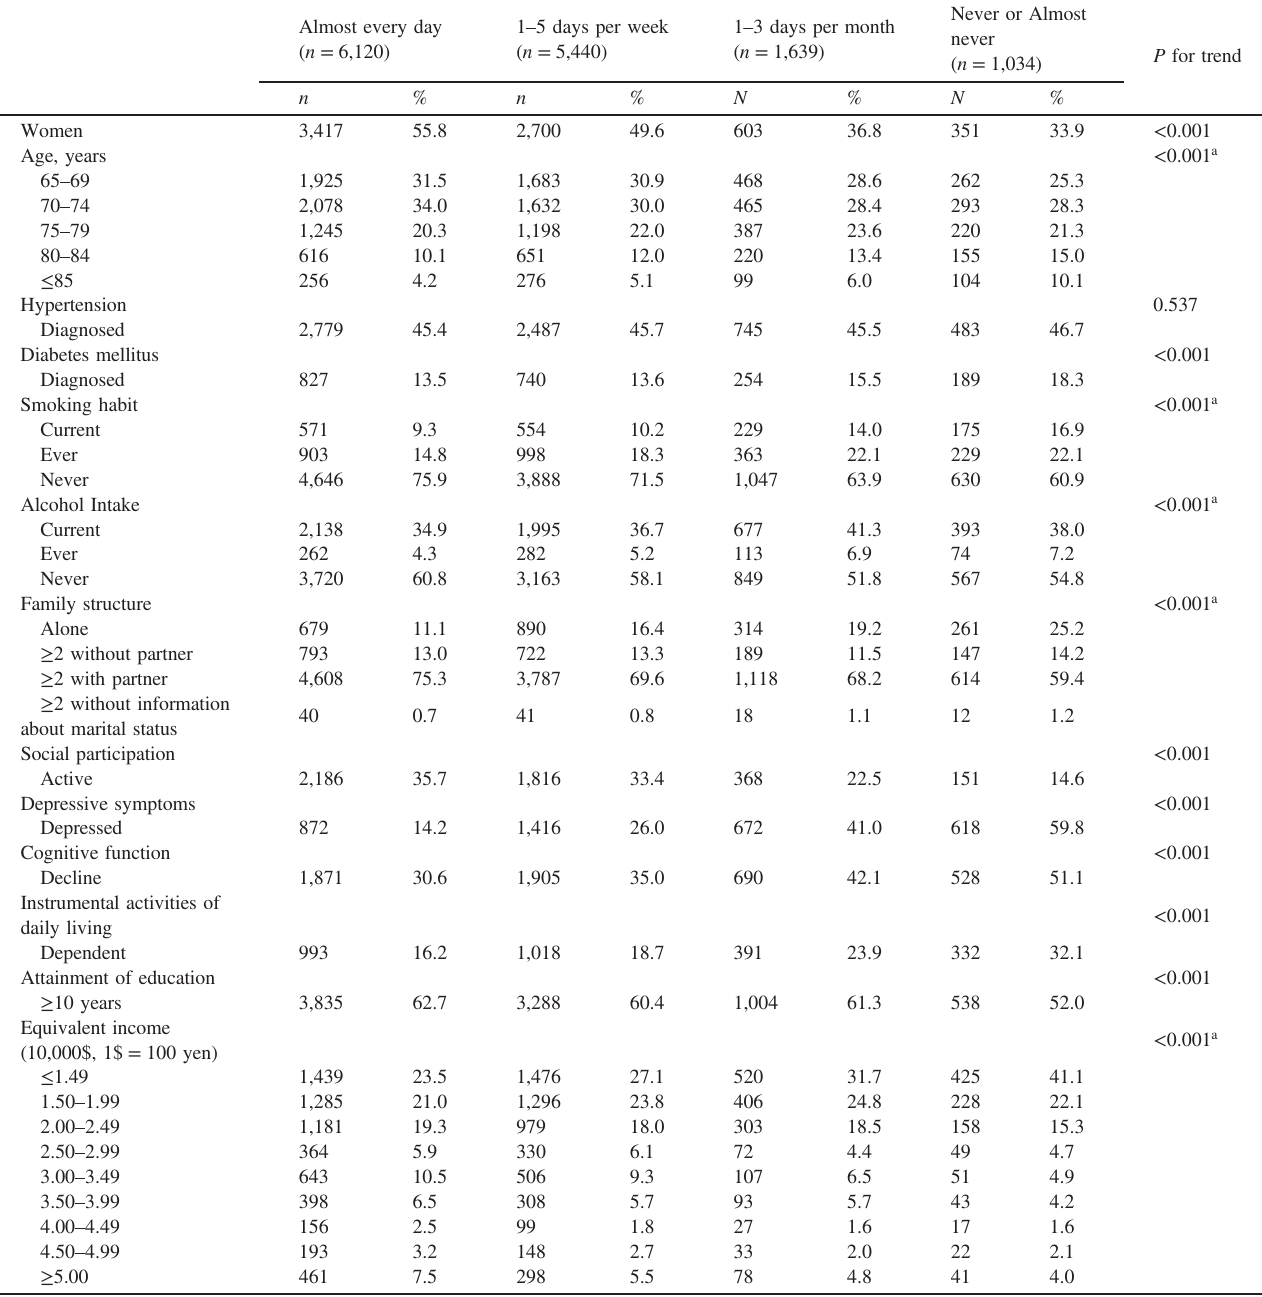
Table 1. Baseline characteristics of the study population by the frequency of